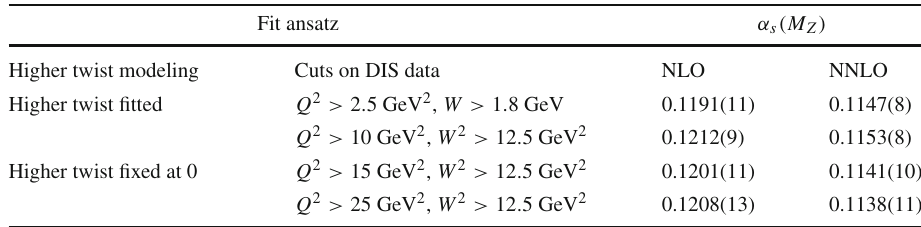
Table 2 The values of α s ( M Z ) obtained in the NLO and NNLO variants of the ABMP16 fit with various kinematic cuts on the DIS data imposed and different